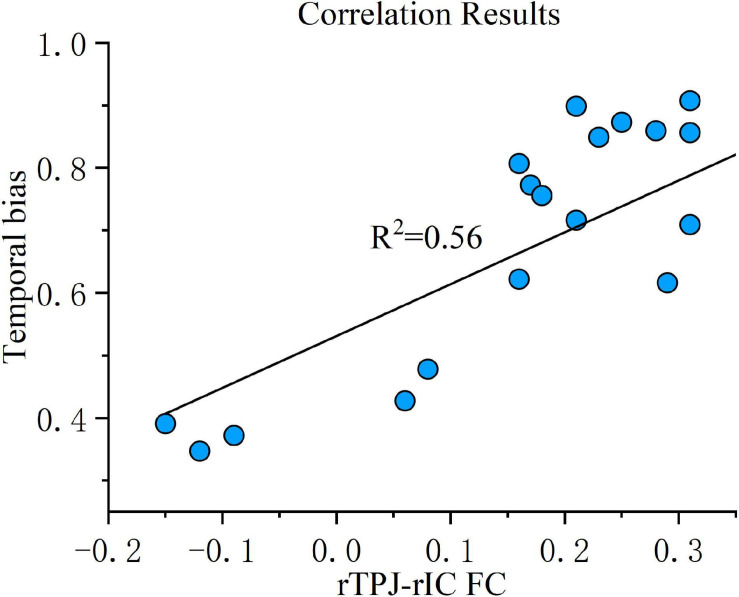
Correlation results. FC change between the right TPJ and the right IC was correlated with temporal bias across all subjects under the real tDCS condition. The coefficient of determination, denoted R2 in the figure, is the proportion of temporal bias that can be predicted from FC variation. FC, functional connectivity; rTPJ, right temporoparietal junction; rIC, right insular cortex.